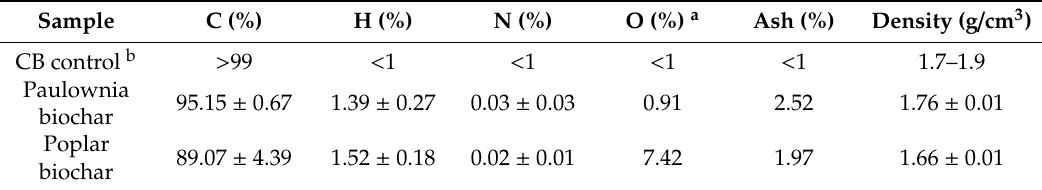
Table 2. Material Properties of CB and Coppiced Hardwood